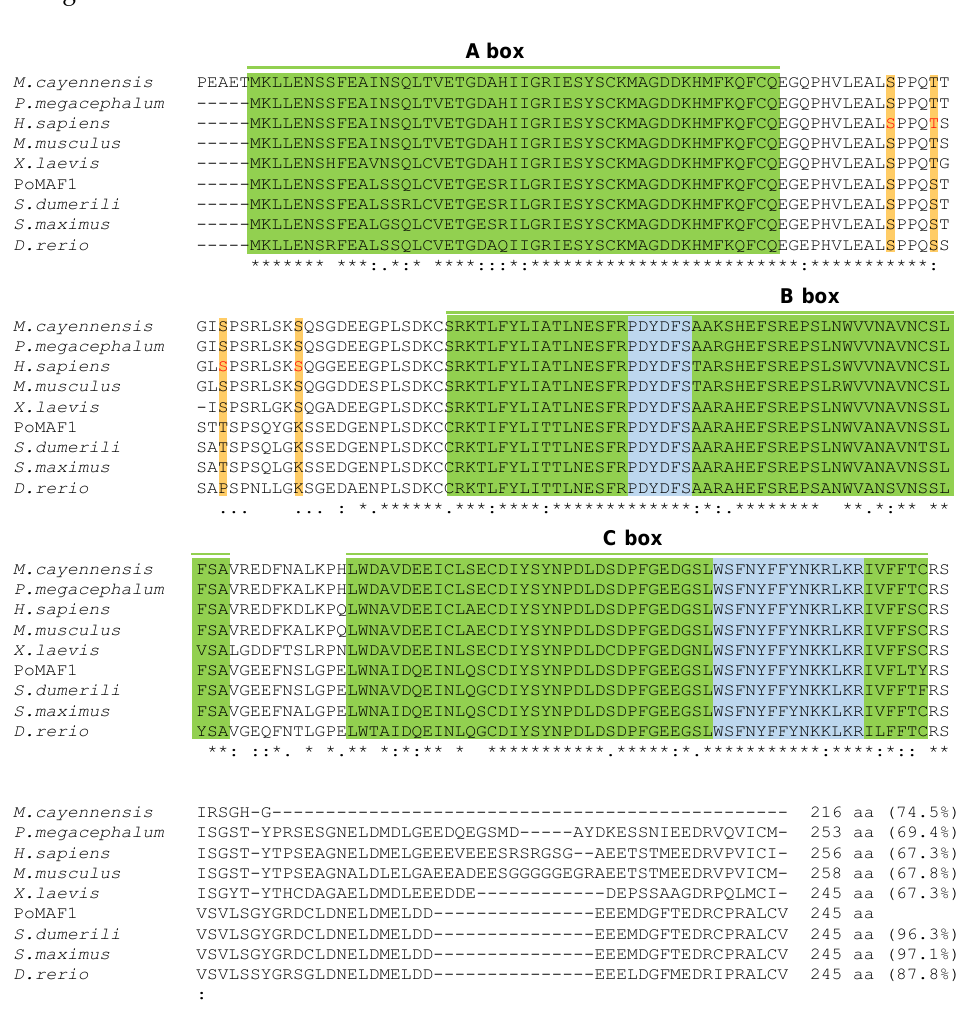
FSAVREDFNALKPHLWDAVDEEICLSECDIYSYNPDLDSDPFGEDGSLWSFNYFFYNKRLKRIVFFTCRS P.megacephalum